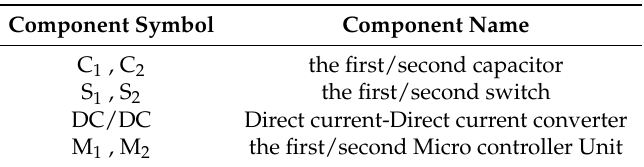
Table 1 is the abbreviation of the name of the experimentally related components. Table 1. Component symbols.